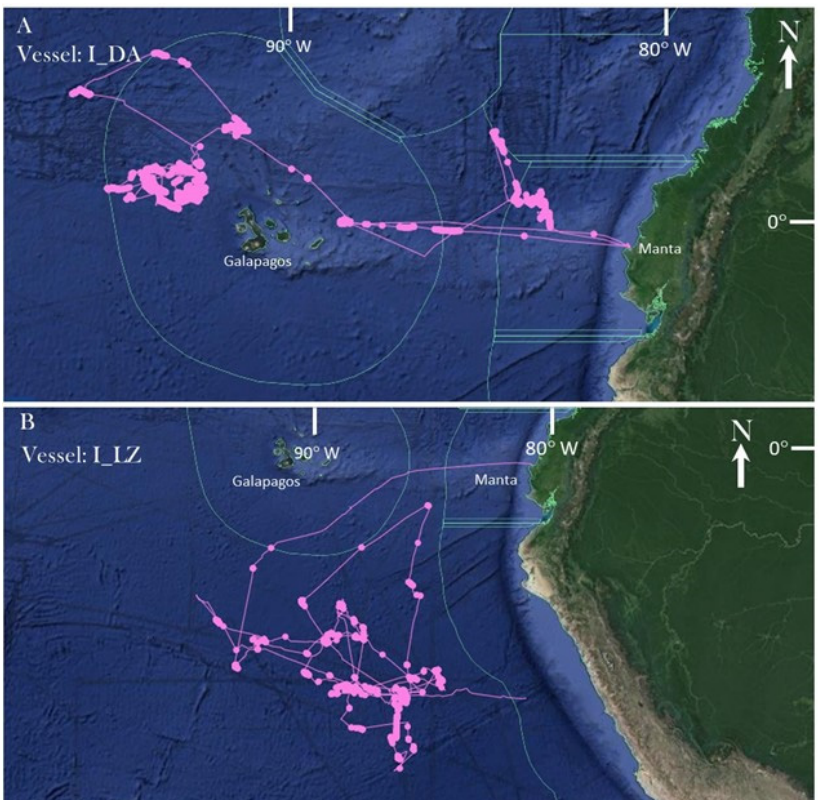
Figure 2. Fishing route (pink line) of industrial fishing vessels ( A ) I_DA and ( B ) I_LZ based on AIS information. Fishing duration was 35 and 76 days, respectively. Green line indicates Economic Exclusive Zones of 200 nautical miles from shore. Imagery adapted from GlobalFishingWatch.org.